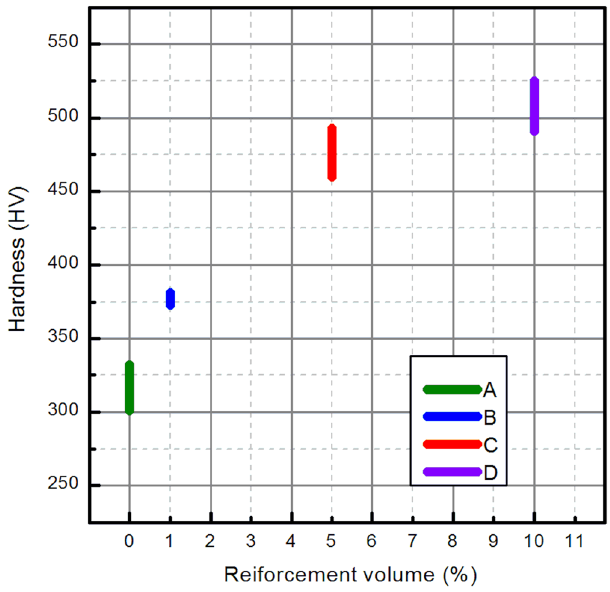
Figure 6. Hardness of Ti6Al4V based composites plotted against the content of the ceramic reinforcement.